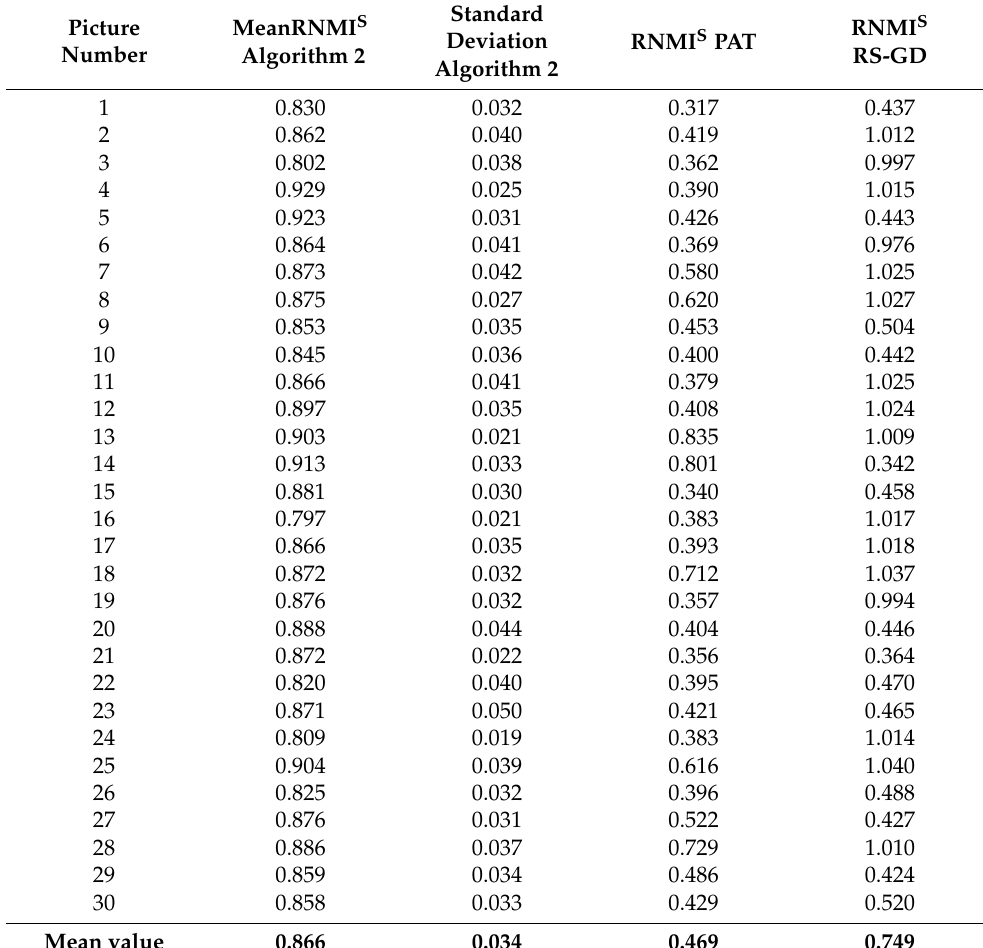
Table 3. The RNMI S values—Algorithm 2, PAT and